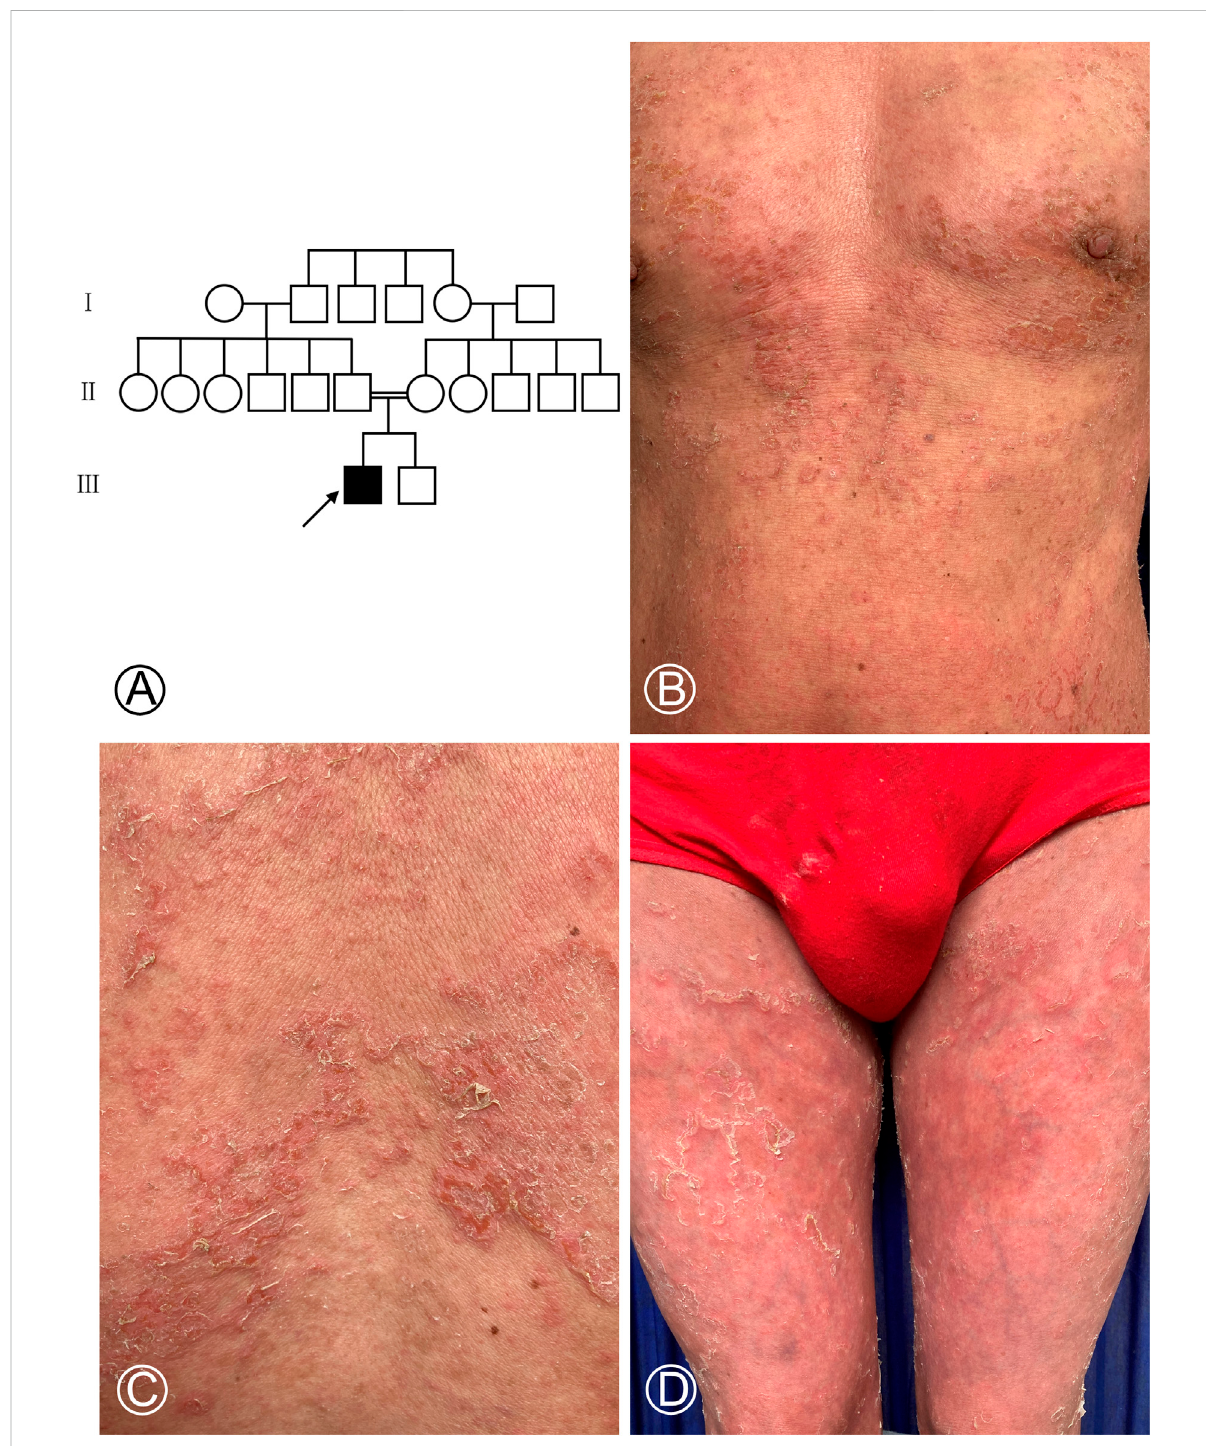
FIGURE 1 Pedigree chart of the NS-affected family and cutaneous manifestations of the proband. (A) Proband is marked with an arrow. Females were indicatedbycircles,whilemaleswereindicatedbysquares.Theblackenedsymbolrepresentedadiseasedmember. (B – D) Diffuseerythemacovered with greyish white scales on the chest, abdomen, and both thighs and scattered multiple blisters in the